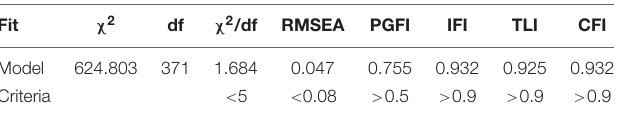
TABLE 8 | Fitting index of second-order model for regional soft environment ( N =